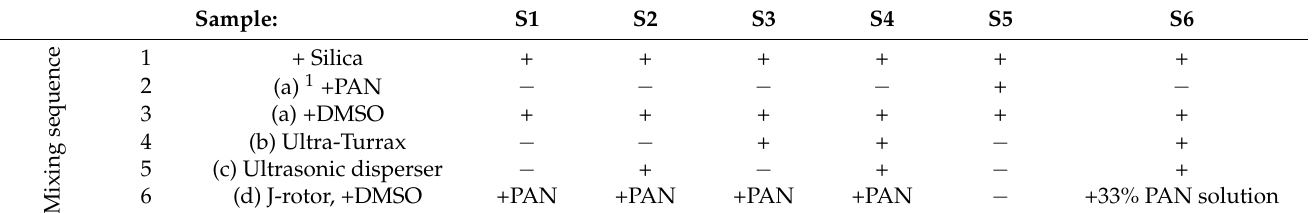
Table 1. Scheme for the preparation of silica-filled PAN solutions. Plus means a particular treatment or ingredient was implemented, while minus means that it was not.